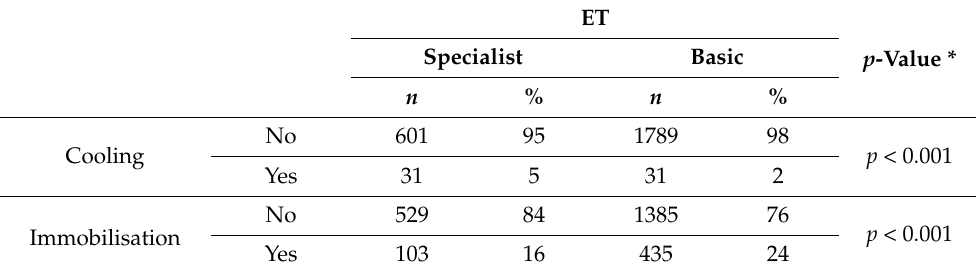
Table 5. The frequency of immobilisation and cooling used by different types of